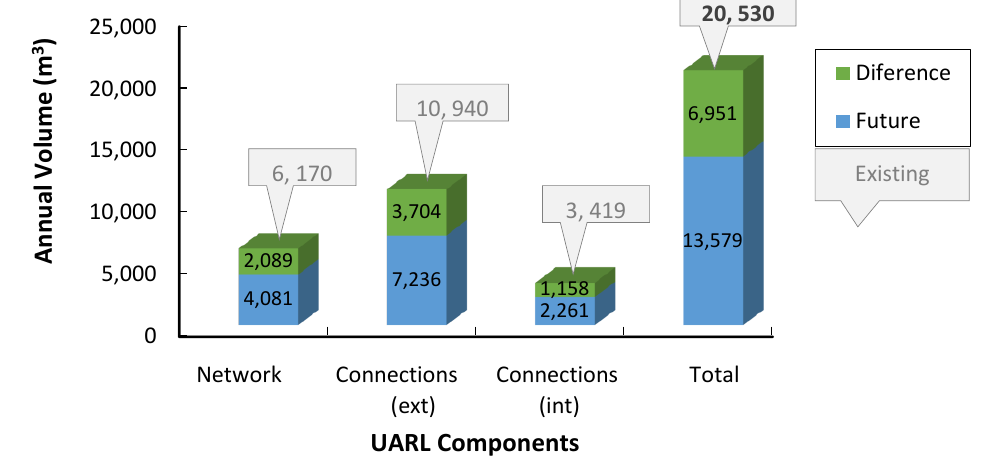
Figure 16. UARL in the components of the Gaula WDN.